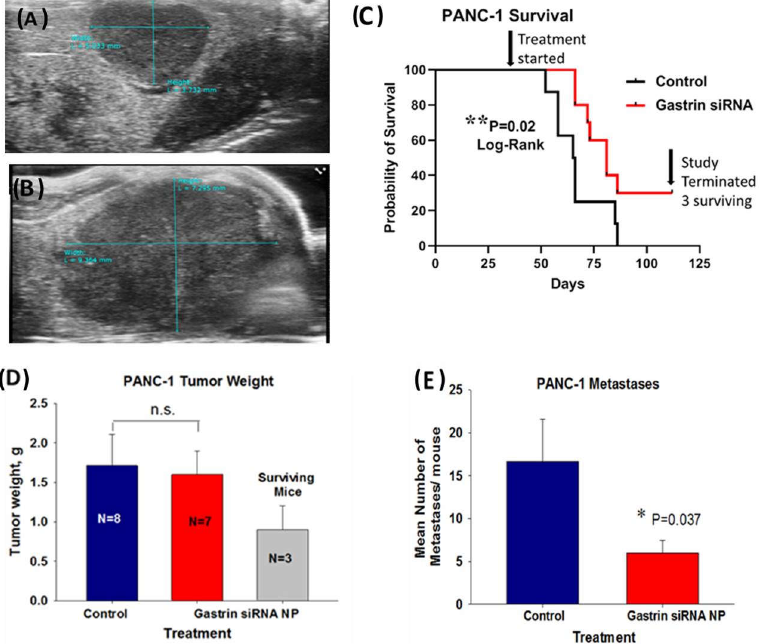
Figure 5. Treatment of mice with a large PANC-1 tumor burden and late disease with a NP loaded with GAST siRNA still improves survival and decreases metastases. ( A ) A representative ultrasound image confirms the presence of a PANC-1 tumor one week after inoculation. ( B ) A r epresentative abdominal ultrasound of a mouse is shown 5 weeks after PANC-1 inoculation and at the initiation of therapy with an extensive large tumor. ( C ) Kaplan Meier survival curve shows im- proved survival benefit ( p = 0.02) in mice treated with NP loaded with GAST siRNA. Top arrow points to the time when the treatment was started. The second arrow on the right points to the time when the study was terminated and to the N = 3 surviving mice in the GAST siRNA-treated group over 1 month after the last control mouse had died. ( D ) Final tumor weights in grams are shown for the N = 8 control mice and GAST siRNA NP- treated mice that died during the study. The tumor weights of the N = 3 GAST siRNA NP treated surviving mice are shown. ( E ) The mean number of metastases counted and confirmed histologically was significantly less in the GAST siRNA -treated mice compared to control ( p = 0.037). * p < 0.05; ** p =